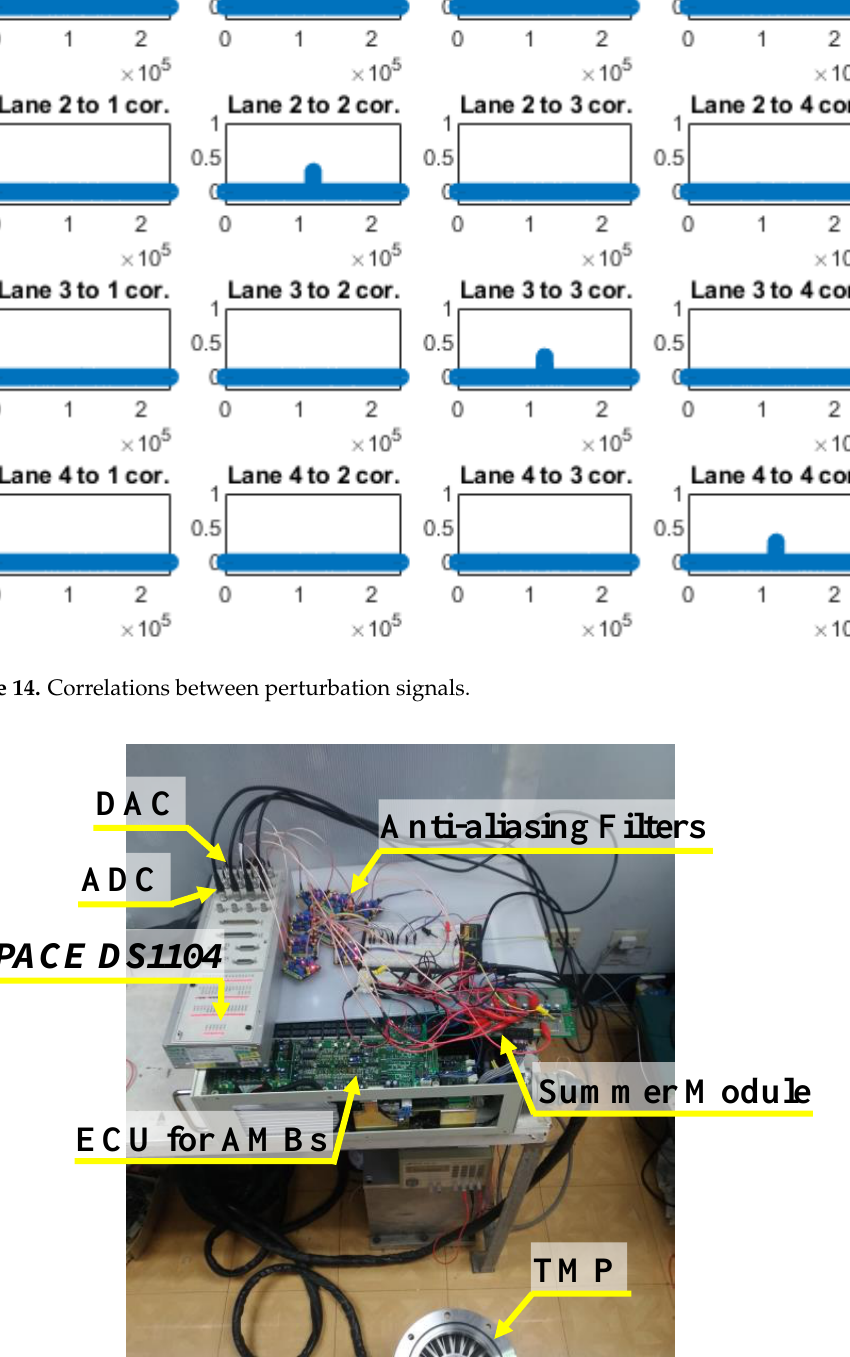
Figure 13. First 200 points of PAPRBS.